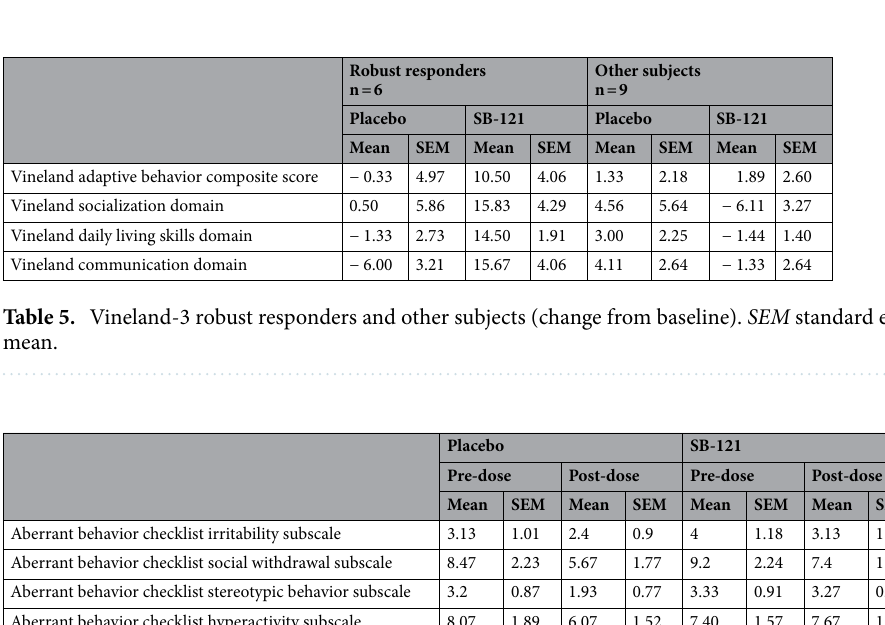
Figure 3. Vineland-3 change from baseline scores—robust responders and other subjects (mean, SEM).